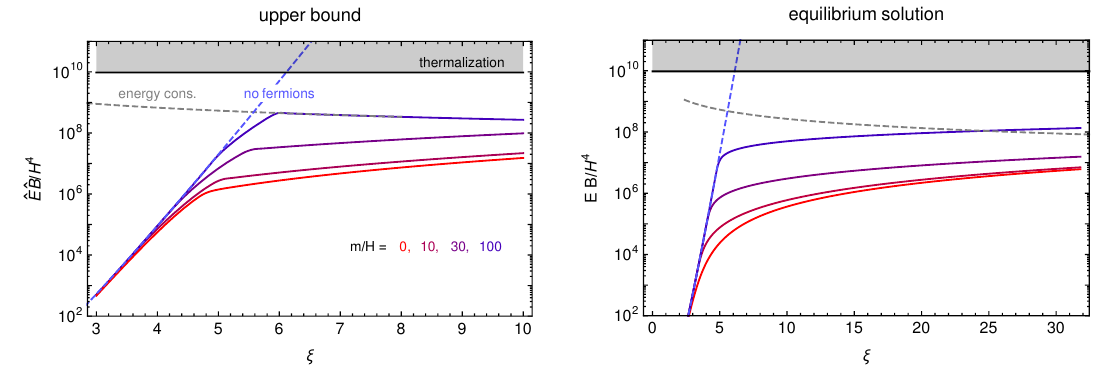
Figure 6 . Magnitude of the Chern-Simons term generated in the presence of charged fermions with mass m=H = f 0 ; 10 ; 30 ; 100 g (red to blue, i.e., bottom to top). Left panel: upper bound obtained by extremizing over eq. (4.14). Right panel: equilibrium solution obtained by selfconsistently replacing (cid:24) 7! (cid:24) e(cid:11) in eq.